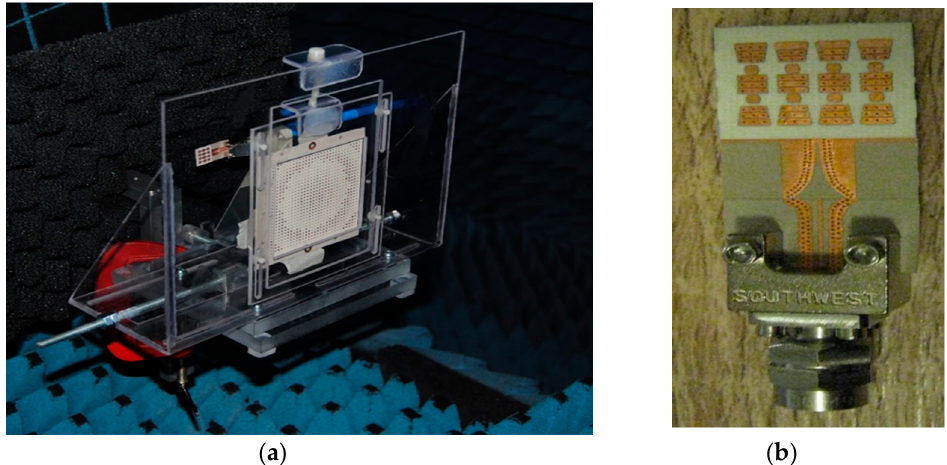
Figure 38. V-band antenna array measurement: ( a ) mounting in anechoic chamber; ( b ) feed antenna.